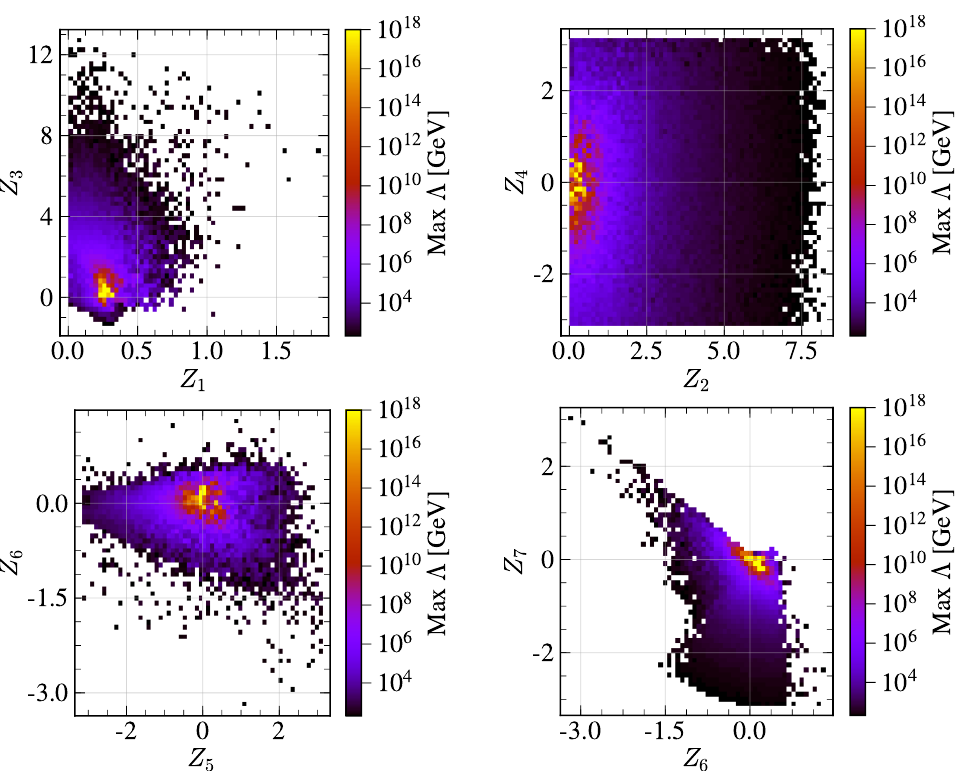
Figure 16 . The maximum breakdown energy scale as a function of quartic couplings in the Higgs basis in the parameter scan of scenario